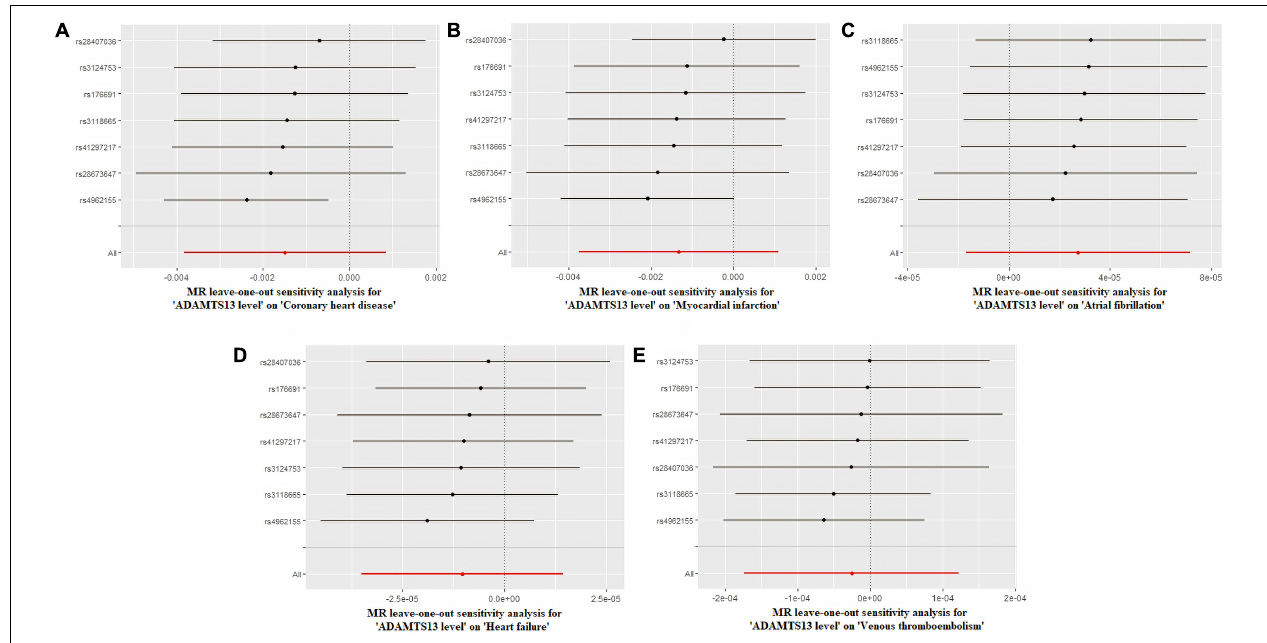
FIGURE 2 | Leave-one-out analysis of ADAMTS13 level. (A) Coronary heart disease, (B) myocardial infarction, (C) atrial fibrillation, (D) heart failure, and (E) venous thromboembolism.